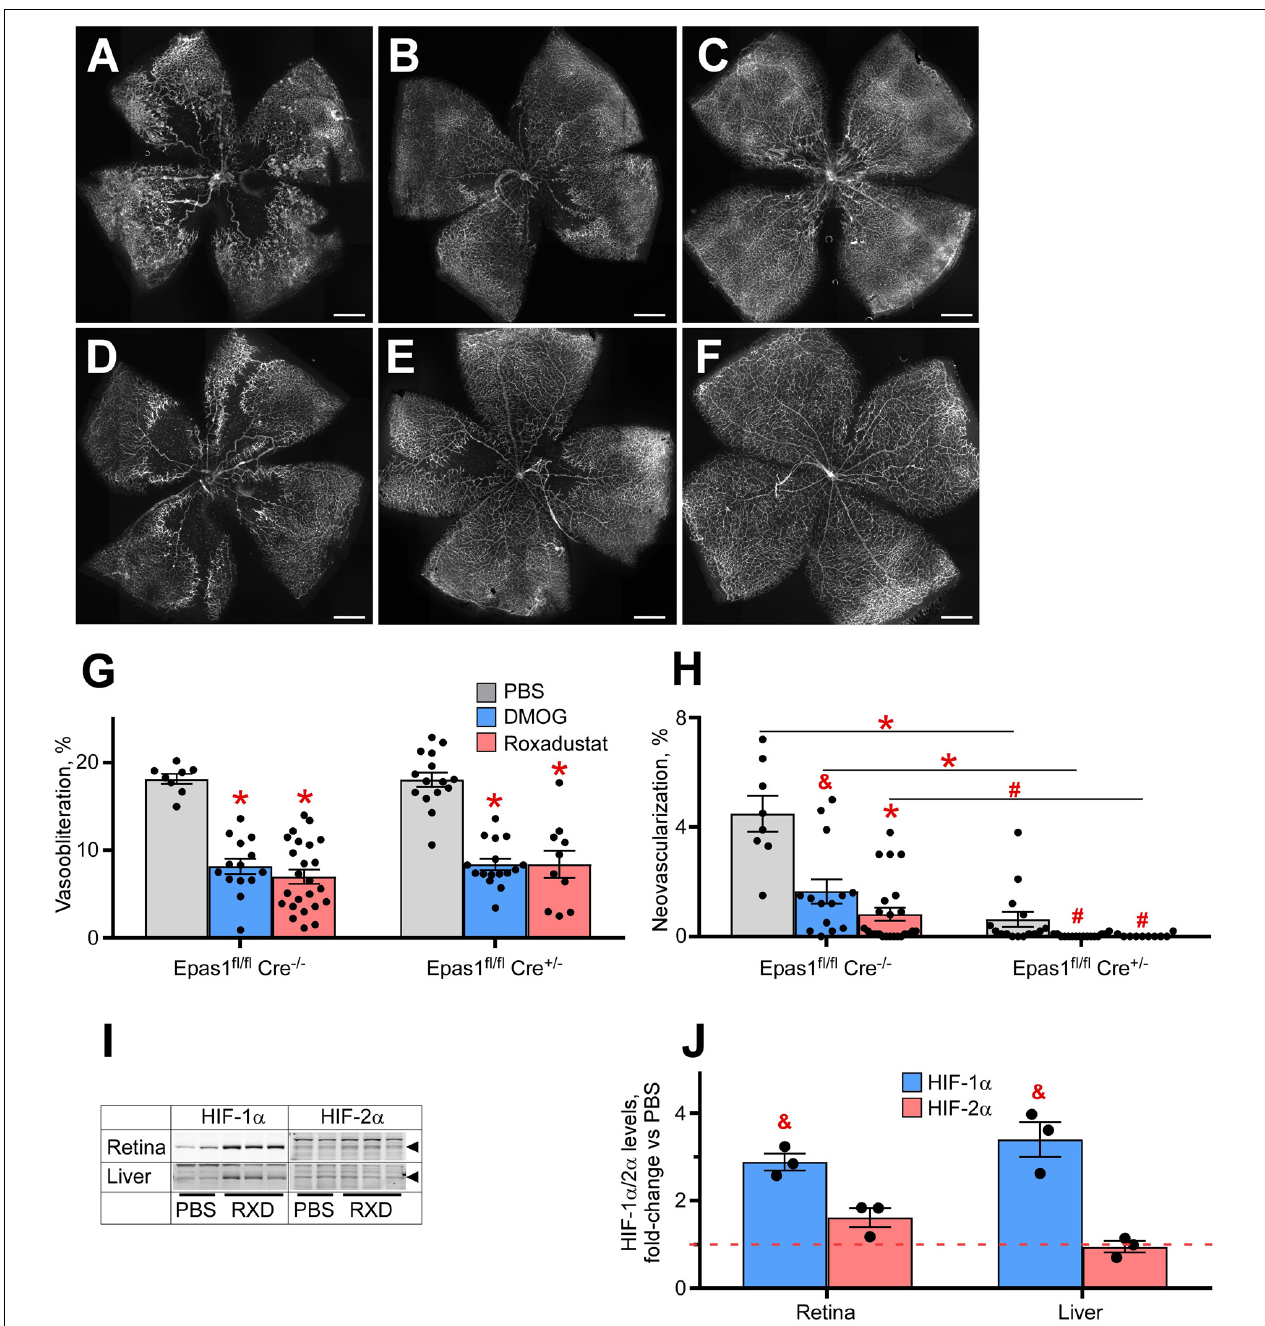
FIGURE 5 | Effect of HIF-2 α deletion from the retinal Müller cells on drug-induced HIF stabilization and OIR prevention. (A–F) Representative retinal flatmounts of the P17 wild-type (A–C) or Müller cell-specific HIF-2 α KO (D–F) mouse pups subjected to hyperoxia from P7 to P21 and thrice injected with 200 µ g/g DMOG (B,E) or 10 µ g/g Roxadustat (C,F) at P6, P8 and P10. Scale bar = 500 µ m. (G,H) Quantification of the retinal capillary loss area [vasoobliteration, (G) ] and vascular tufts area [neovascularization, (H) ] in retinal flatmount images demonstrated in panels (A–F) . Epas1 fl / fl :Cre − / − , PBS, n = 8; DMOG, n = 14; Roxadustat, n = 24. Epas1 fl / fl :Cre ± , PBS, n = 15; DMOG, n = 16; Roxadustat, n = 10. (I) Western blot analysis of HIF-1 α /2 α protein levels in the liver and retina of the P8 Müller cell-specific HIF-2 α KO mouse pups 3 h after injections with PBS or 10 µ g/g Roxadustat (RXD). (J) Semi-quantitative analysis of HIF-1 α and HIF-2 α protein levels by densitometry of the western blotting images shown in panel (I) plotted as fold-change vs PBS injection (red dashed line), n = 3 for each experimental condition. P values are presented as follows, * ≤ 0.0001; $ ≤ 0.005; & ≤ 0.01; # ≤ 0.05, and represent statistical difference vs PBS control, unless otherwise indicated as in panel (H) .